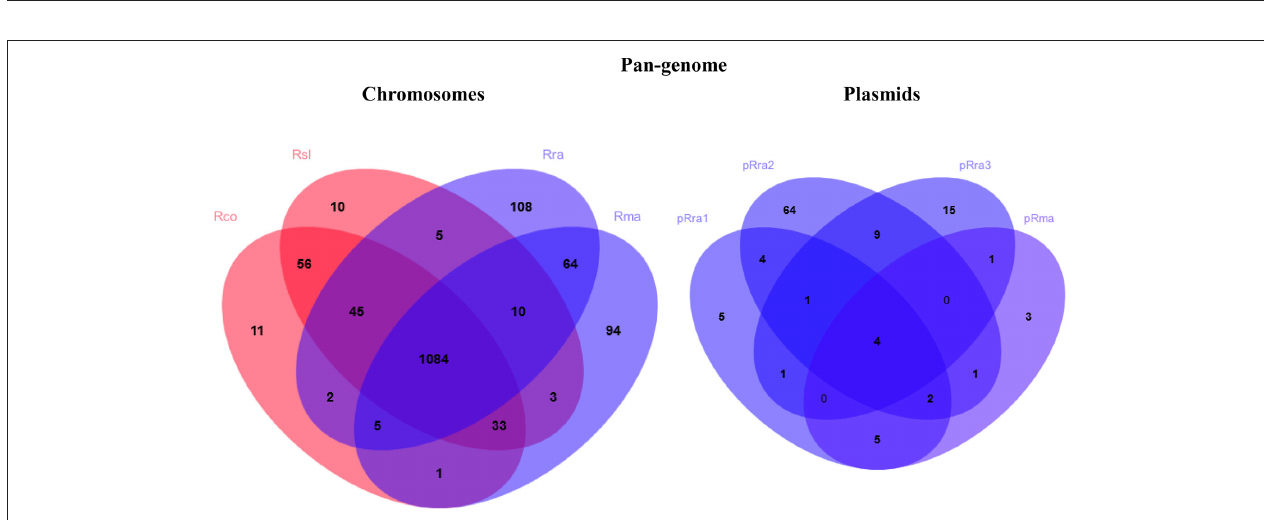
FIGURE 2 | Venn diagrams summarizing pan-genome of the virulent R. slovaca Rsl and the milder R. raoultii Rra causing SENLAT, and the virulent R. conorii Rco and the milder R. massiliae Rma causing MSF.